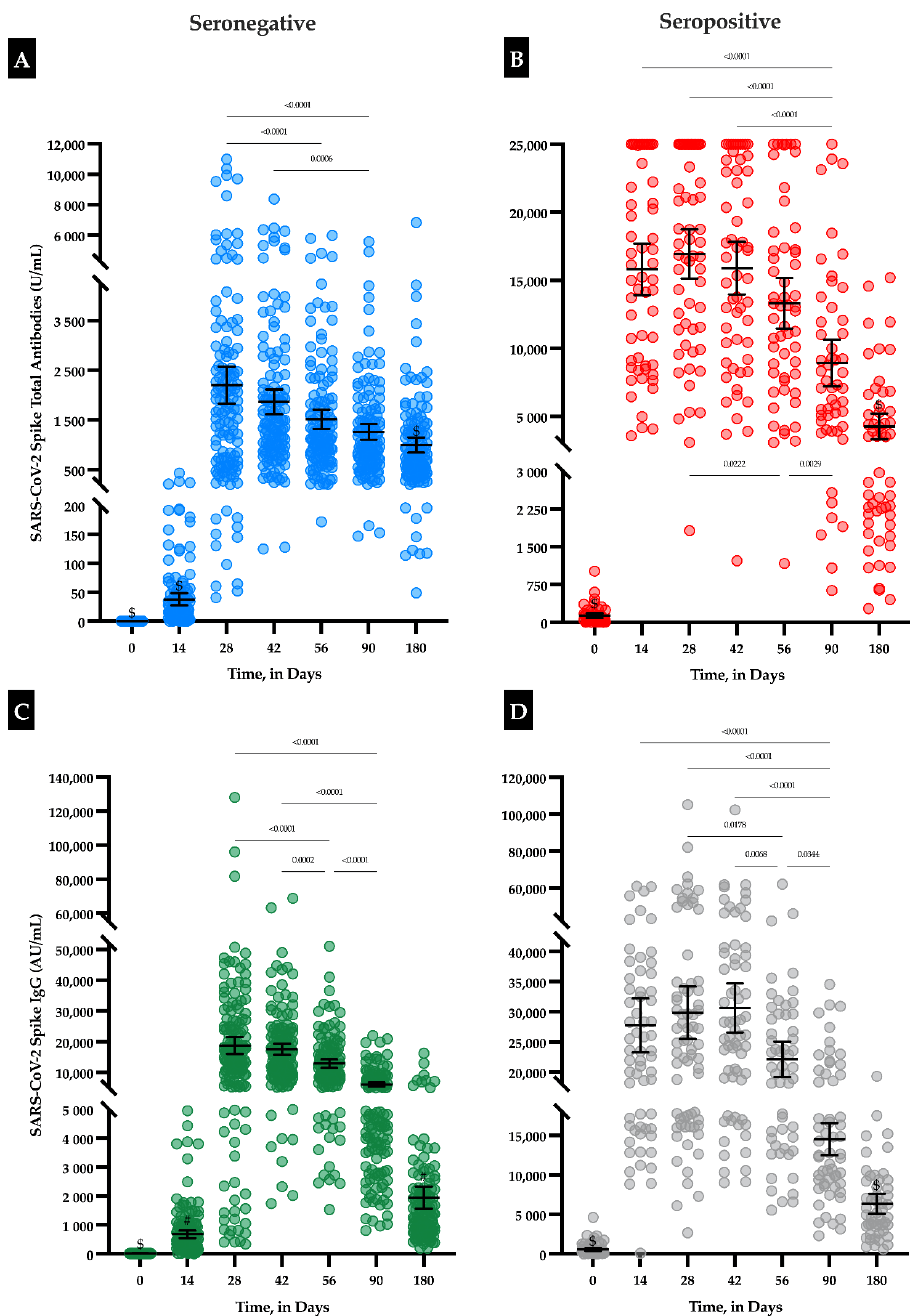
Figure 1. (Previous page). Evolution of SARS-CoV-2 spike antibodies (U/mL) in seronegative (A and C for total antibodies and IgG, respectively) and seropositive individuals (B and D for total antibodies and IgG, respectively) according to the time since the first vaccine dose administration. Means with 95% confidence intervals are shown. ( A , B ) Using the total antibody assay, an automatic dilution of 1/100 at >250 U/mL was performed by the analyzer to extend the measurement do- main up to 25,000 U/mL. A total of 46 samples were rounded to 25,000 U/mL out of 1337 (3.4%). Results < 0.4 U/mL (limit of quantification) were rounded to 0.4. ( C , D ) Using the IgG assay, an automatic dilution of 1/4 at > 40,000 AU/mL was manually performed to extend the measurement domain to 160,000 AU/mL. Results < 21 AU/mL (limit of quantification) were rounded to 21. $, statistically different from all other groups (i.e., p < 0.0001); #, statistically different from all other groups (i.e., p < 0.0001) except between time points 14 and